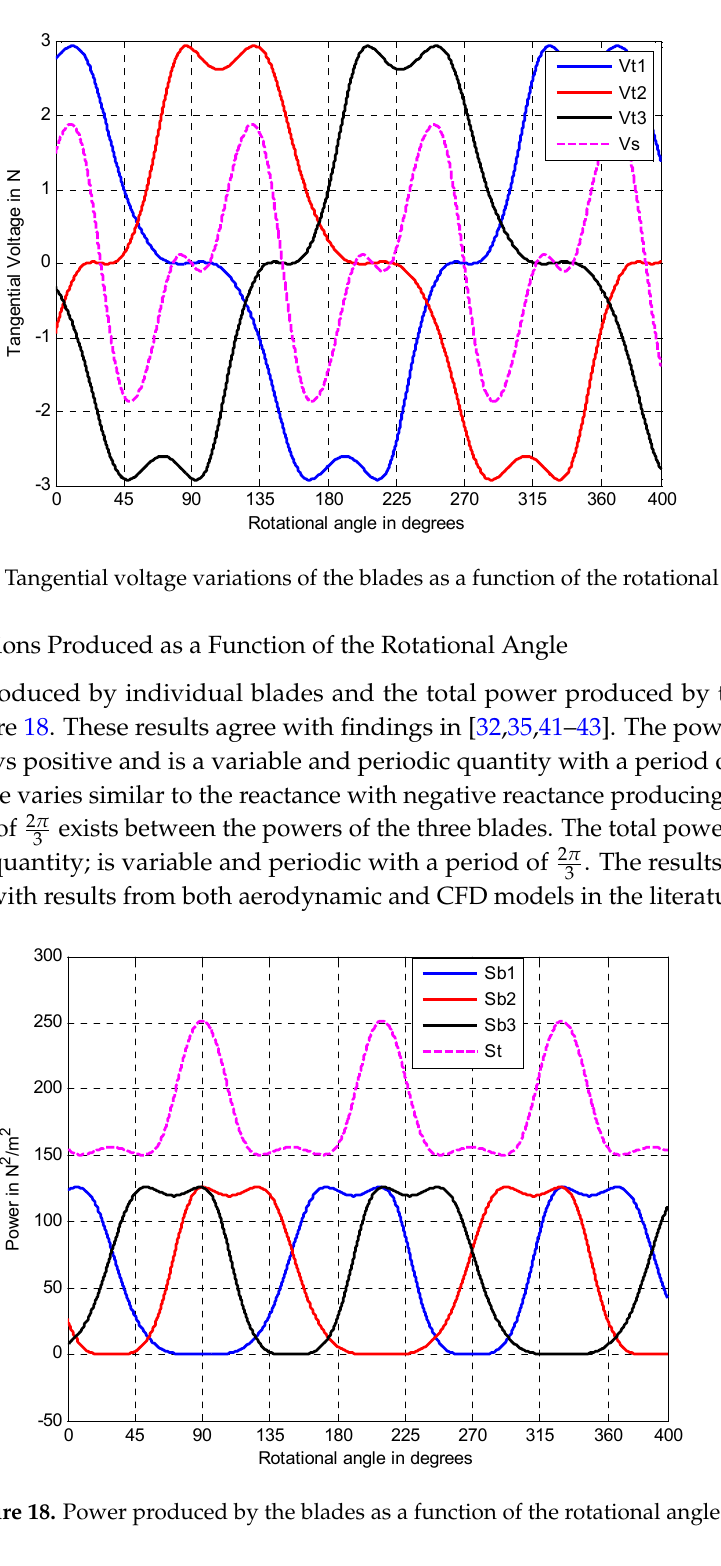
16 of 21 Figure 16. Normal voltage variations of the blade as a function of the rotational angle. The tangential voltage produced by the blade during a complete rotation varies following an alternative and 2 π periodic signal. During a complete rotation of the blade, the tangential voltage is equal to zero at 2  and 2 3  ; these points are also inflexion points that correspond to angles for which the tangential impedance is zero. Similar to the tangential impedance, a valley occurs between